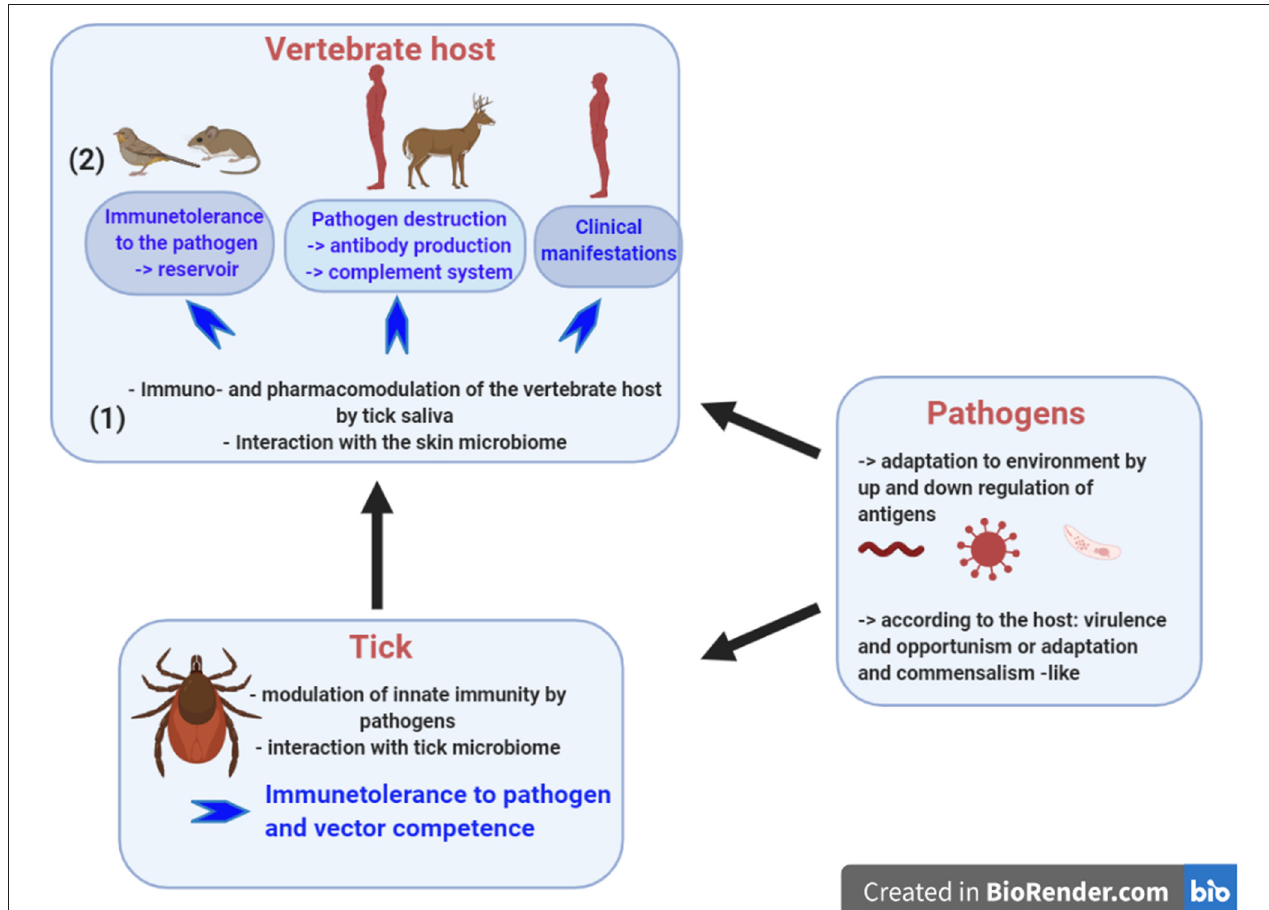
FIGURE 1 | Tick-borne diseases rely on interplays between the tick, the pathogen and the vertebrate host. To be a competent vector, the tick must control the pathogen population by its innate immunity and the tick microbiome seems to contribute to this control. During pathogen inoculation into the skin, tick saliva modulates the pharmacology and the immunology of the vertebrate host. Skin immunity plays a major role in tolerance of tick-borne pathogens. It is likely that the skin microbiome participates in this immunomodulation. Once inoculated, the infection outcome varies: (1) in animal reservoir like rodents, where no clinical manifestations develop and the pathogens survive for months allowing their persistence in the environment; (2) the vertebrate host has a sufficient immune system to neutralize the pathogens and antibody presence provides evidence of contact with the pathogens; and, (3) the vertebrate host does not trigger a sufficient and protective immune response and as a consequence develops clinical disease. Created with